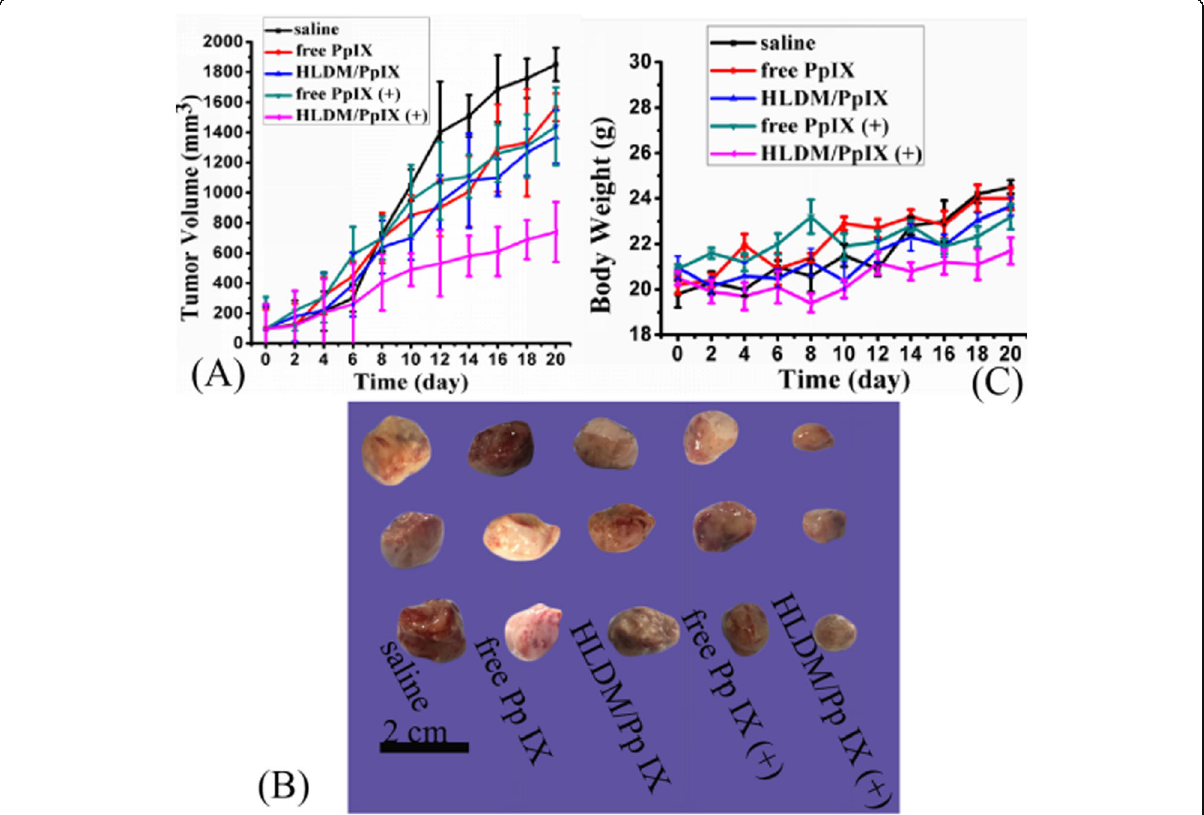
Fig. 10 In vivo antitumor activity and safety evaluation. a Tumor volume changes over treatment times. b Tumor volume of five groups: ( a ) normal saline, ( b ) free Pp IX (5 mg/kg), ( c ) Pp IX-loaded HLDM micelles (5 mg/kg of free Pp IX equivalents), ( d ) free Pp IX (5 mg/kg) plus light